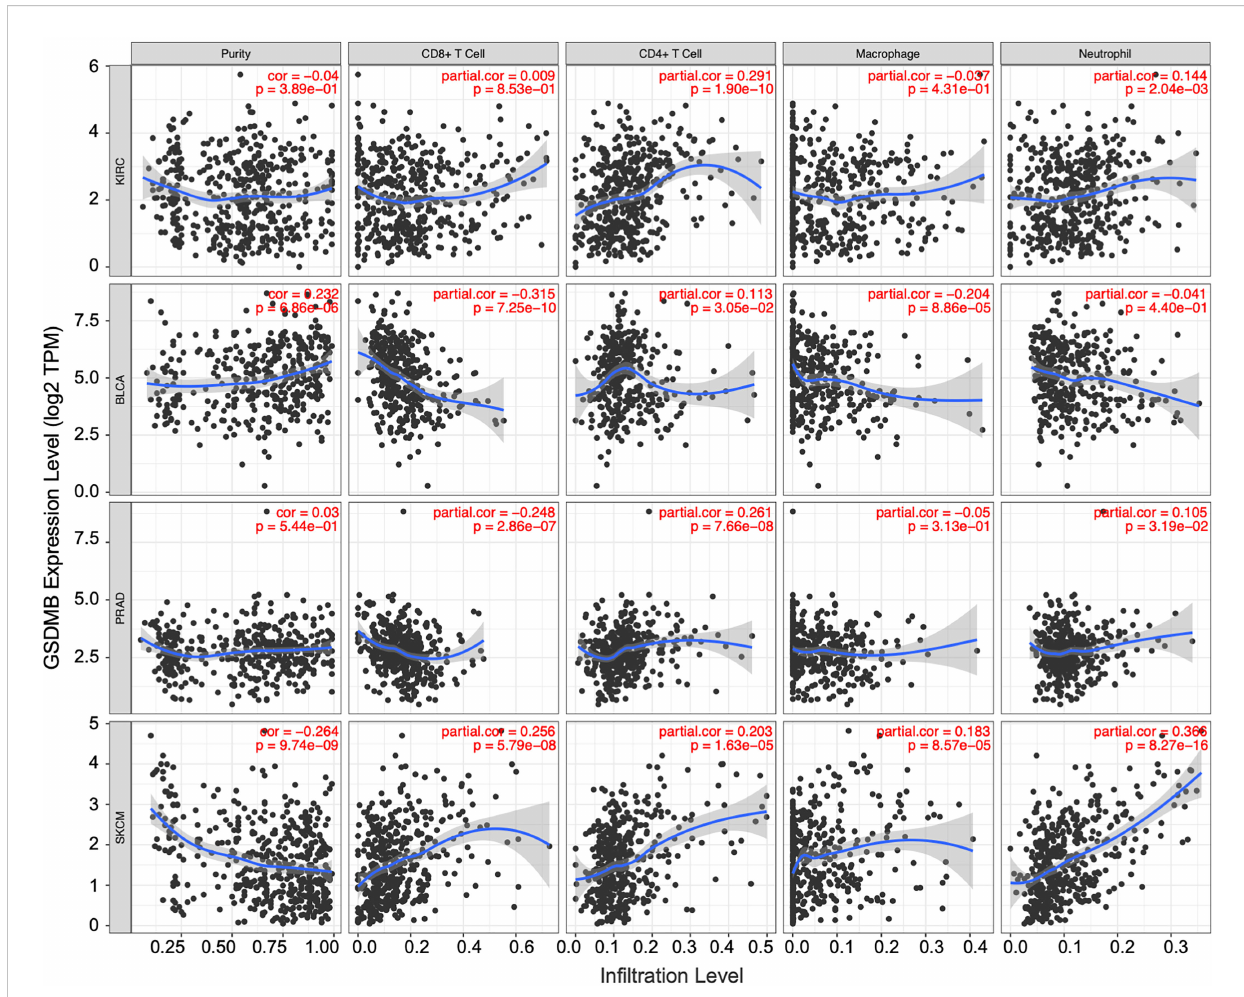
FIGURE 5 The correlation between GSDMB expression and immune in fi ltration levels in diverse cancer types. Generated and displayed scatterplots showing the purity-corrected partial Spearman ’ s rho value and statistical signi fi cance. Gene expression levels for tumor purity are consistently shown on the leftmost panel. The scatter plots of related cancers generated by Spearman ’ s algorithm, including KIRC, BLCA, PRAD, and SKCM. In KIRC, the expression level of GSDMB gene was signi fi cantly and positively correlated with CD4+ T cells. GSDMB, gasdermin B; KIRC, kidney renal clear cell carcinoma; BLCA, bladder urothelial carcinoma; PRAD, prostate adenocarcinoma; SKCM, skin cutaneous